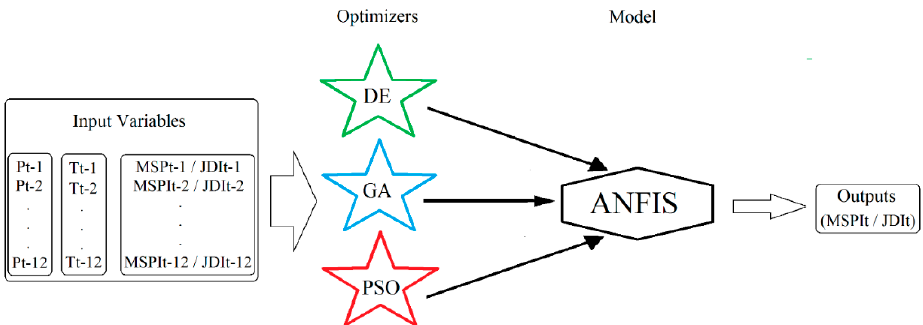
Figure 2. Schematic form of adaptive neuro-fuzzy inference system (ANFIS) merging with the algorithms differential evolution (DE), genetic algorithm (GA) and particle swarm optimization (PSO).